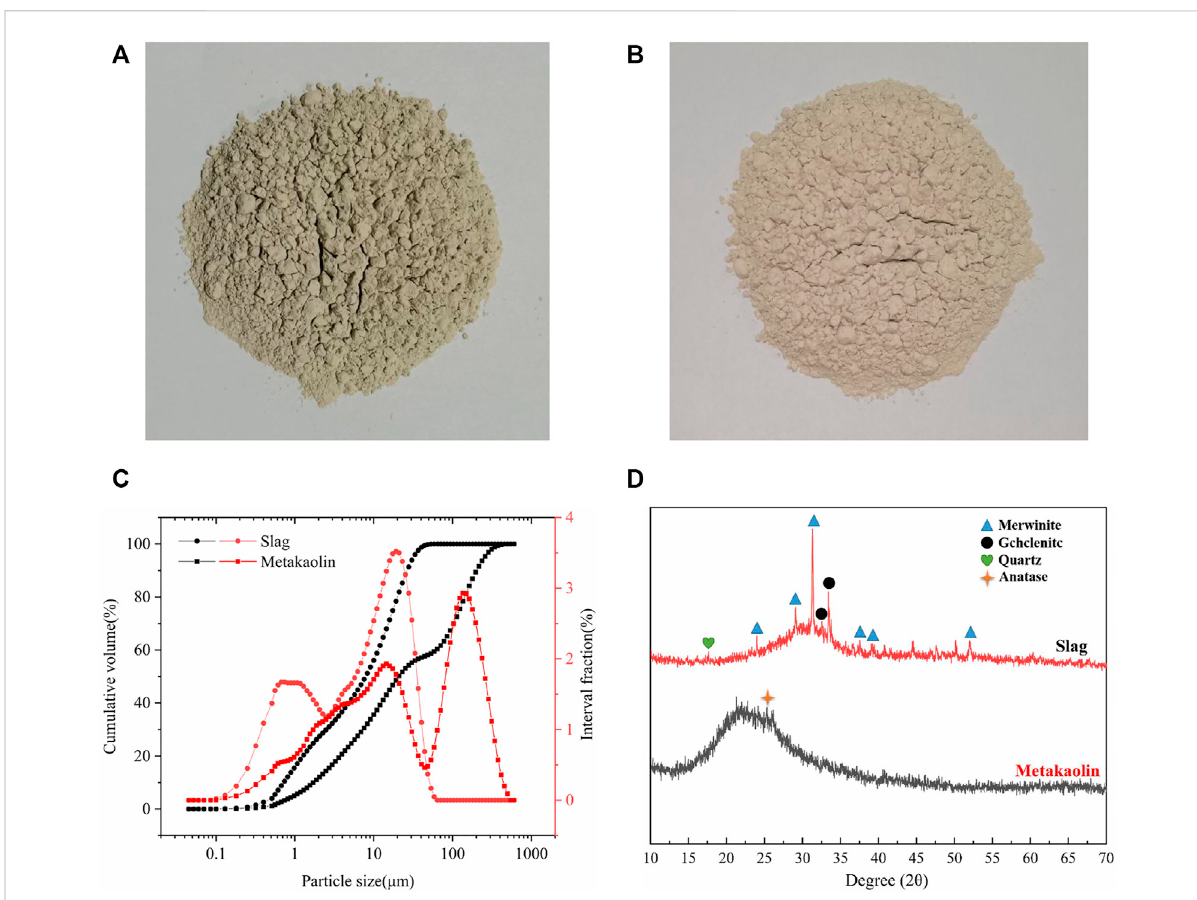
FIGURE 1 Physicochemicalpropertiesofrawmaterials: (A) Slag; (B) Metakaolin; (C) Particlesizedistributionsofslagandmetakaolin;and (D) XRDresultsof slag and